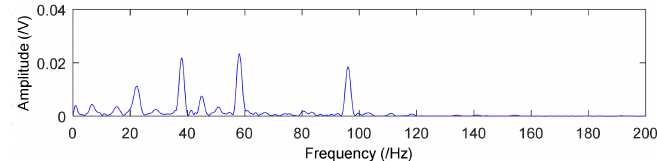
Figure 13. Diagonal slice spectrum after using standard local projection for noise reduction.